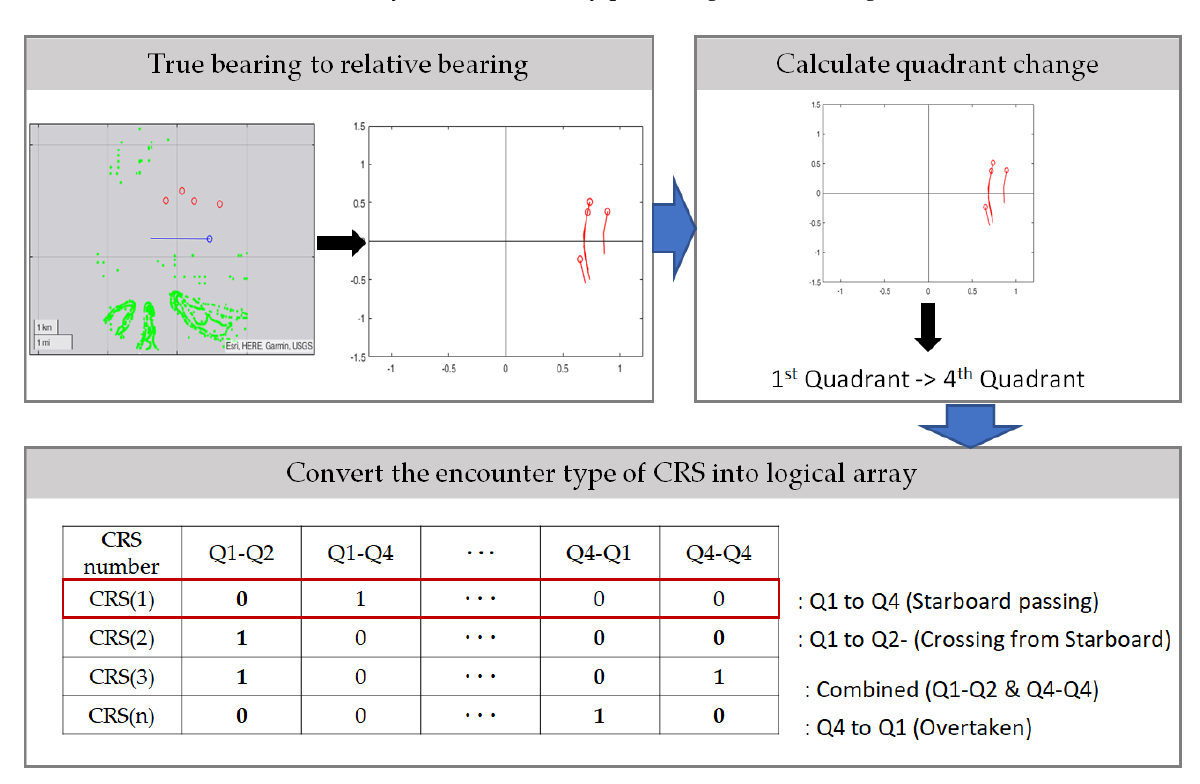
Figure 6. Schematic showing the feature extraction process of a “type of encounter” array. The sample situation was converted into relative bearing and distance in the Cartesian coordinate system. The quadrant changes were calculated and converted as a logical array(red box).